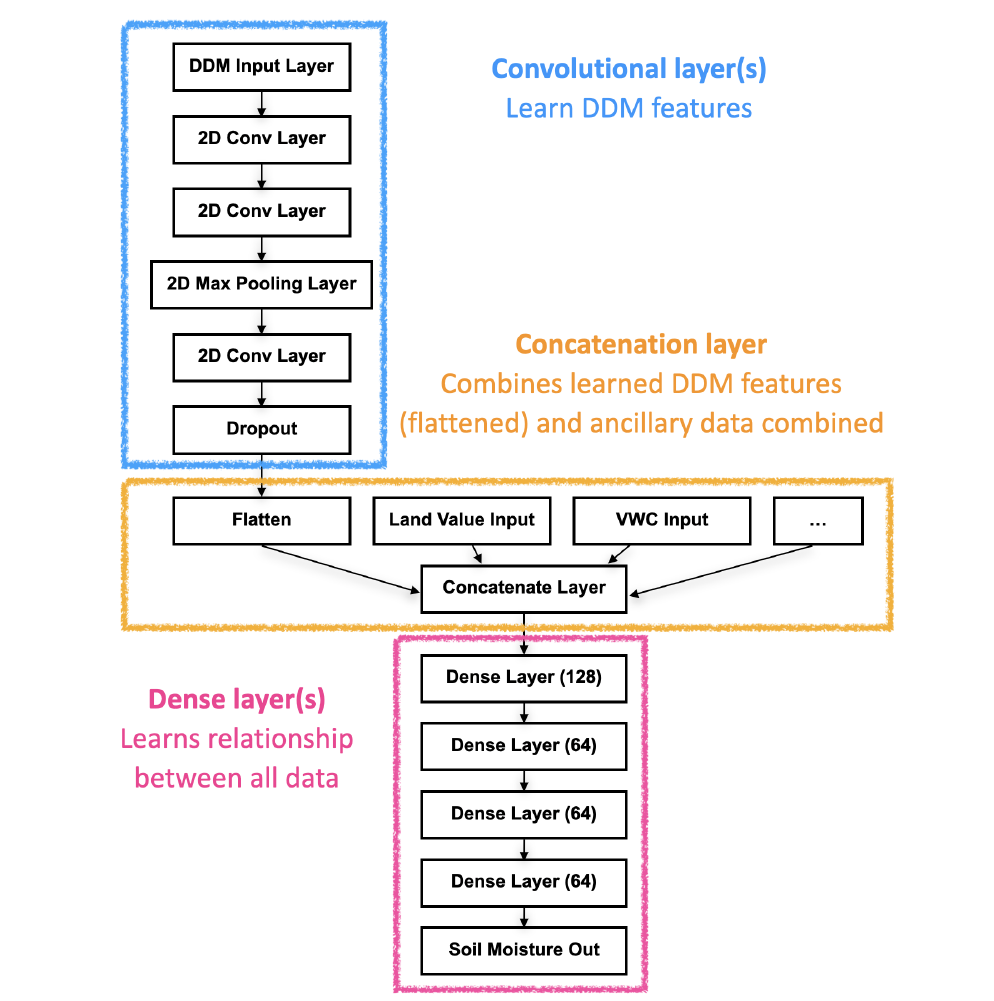
Figure 6. Layout of complete neural network (specific layers exemplary) highlighting functional regions. Here, 2D layers of the DDM subnetwork include convolutional layers, max-pooling layers which downsample using regional maxima from previous layer, and dropout layers which ran- domly remove inputs during training to prevent overfitting. The concatenation layer combines the output of the DDM layers with the ancillary data inputs, and passes these to several dense (fully connected)